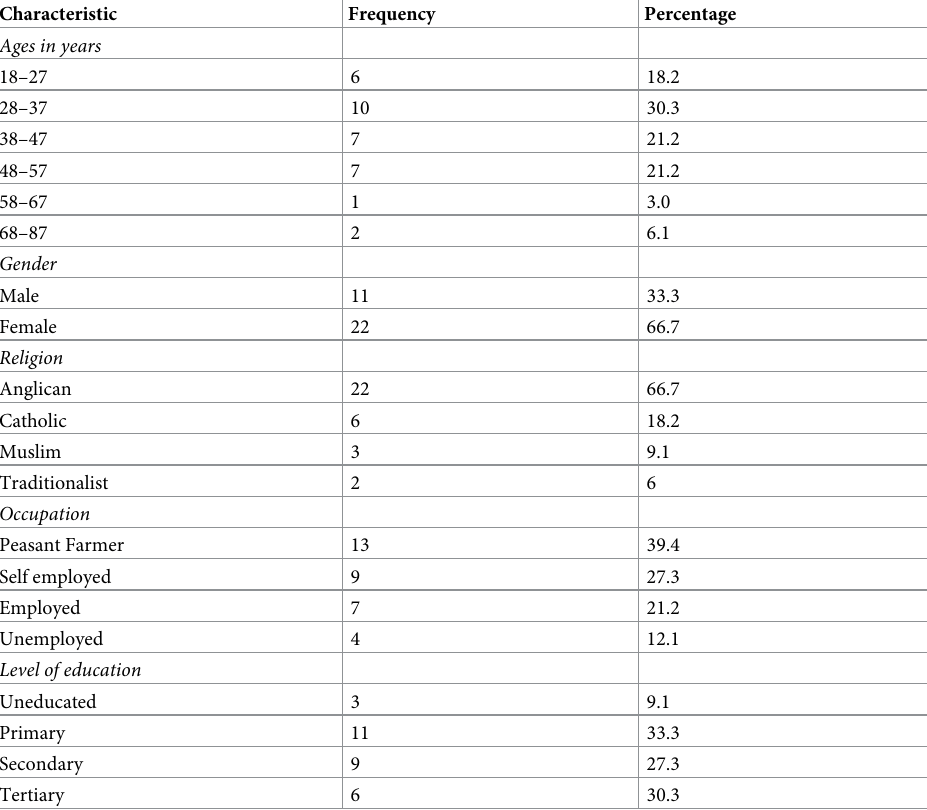
Table 1. Socio demographic characteristics of study